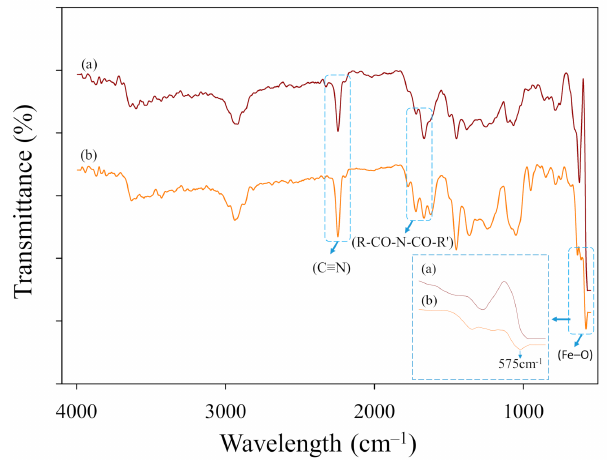
Figure 2. ATR-FTIR curves of composite nanofiber membranes ( a ) PEI-AN, and ( b ) Fe/PEI-AN.